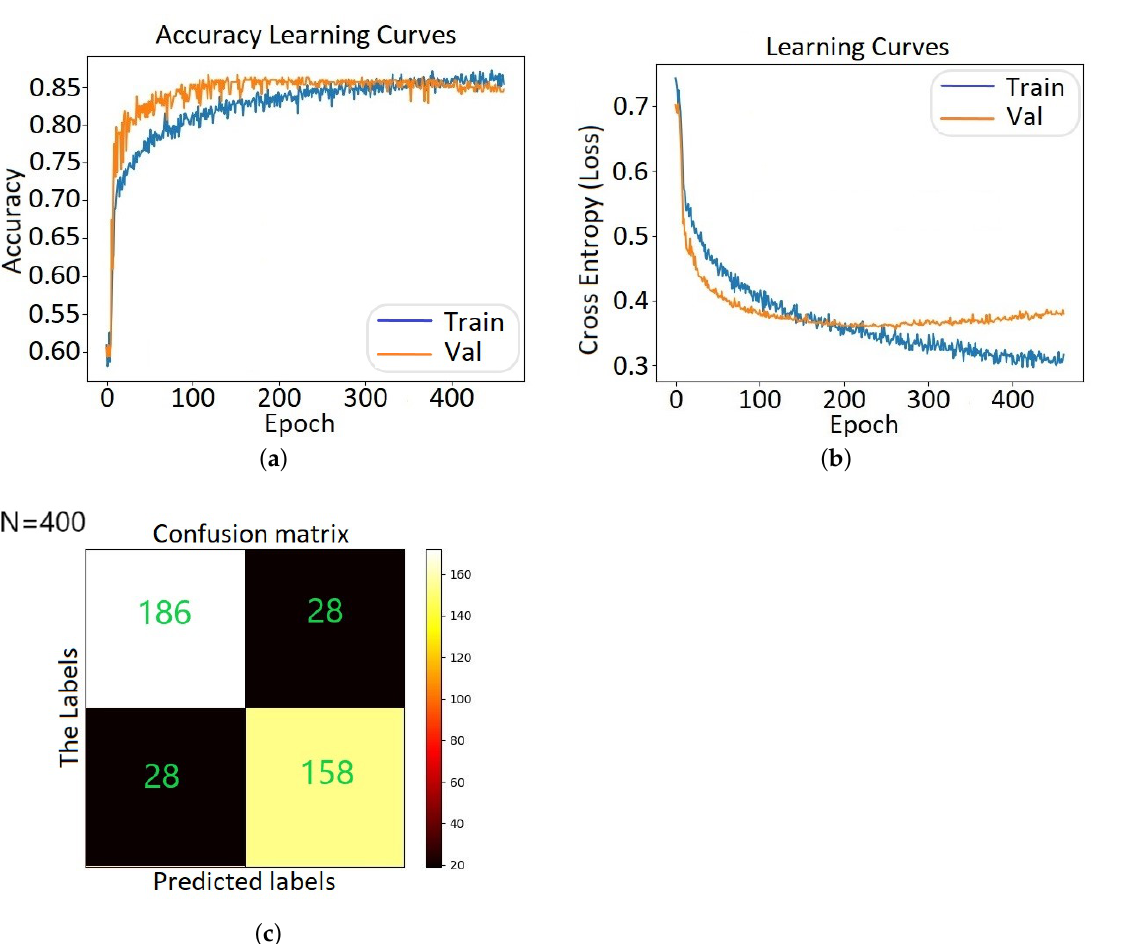
Figure 10. Performance curves of the DNN model: ( a ) accuracy; ( b ) cross entropy (loss); ( c ) confusion matrix.